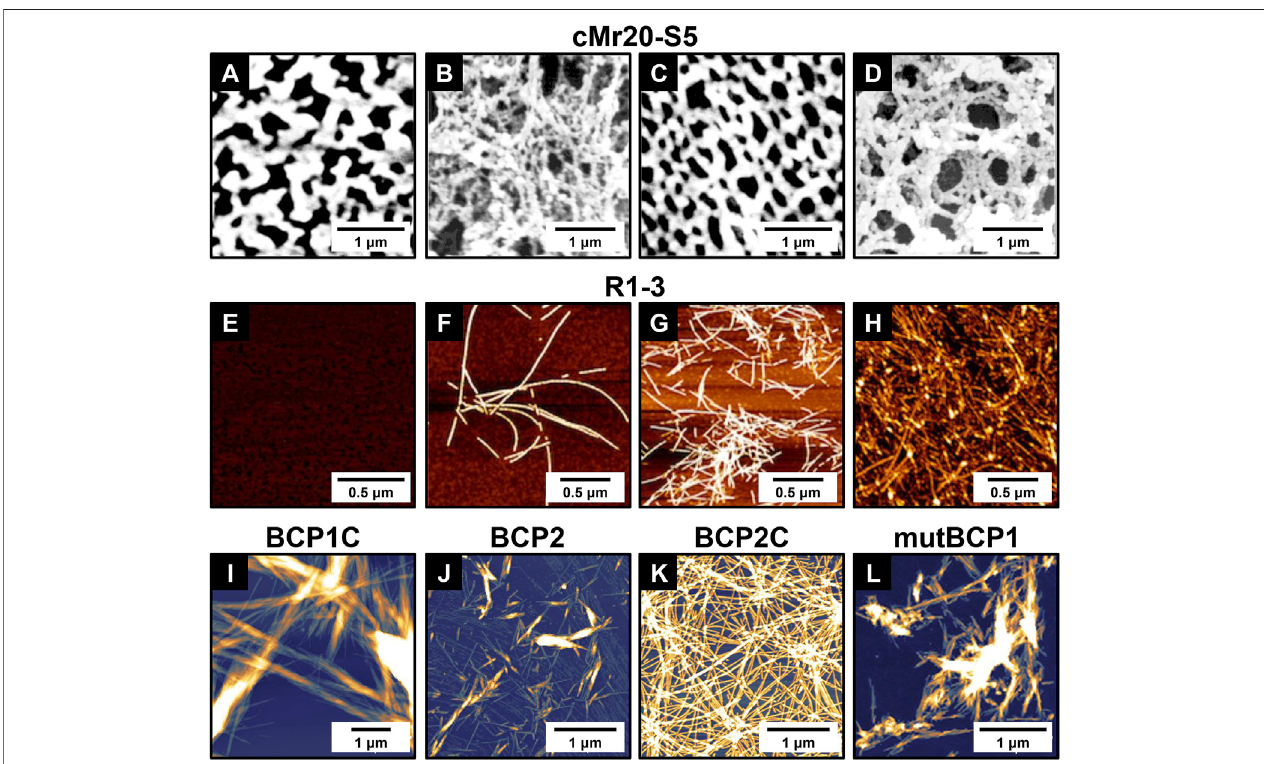
FIGURE4| Self-assembledstructuresofrepresentative barnacle-inspired peptides. (A) AFM and (B) SEM images ofcMr20-S5 assemblies inPBS supplemented with1 M NaCl; (C) AFM and (D) SEM images ofcMr20-S5 assemblies in1 MNaCl with alkaline preincubation. AFM images of R1-3 incubated at pH 4.0 for (E) 5 min or (F) > 2 weeks and at pH 9.0 for (G) 5 min or (H) > 2 weeks. AFM images showing the self-assembled nanostructures from (I) BCP1C, (J) BCP2, (K) BCP2C, and (L) mutBCP1. (A – D) Adapted with permission from Nakano et al. (2007). Copyright 2007, American Chemical Society. (E – H) Adapted with permission from Nakano and Kamino (2015). Copyright 2015, American Chemical Society. (I – L) Adapted with permission from So et al. (2019). Copyright 2019, American Chemical